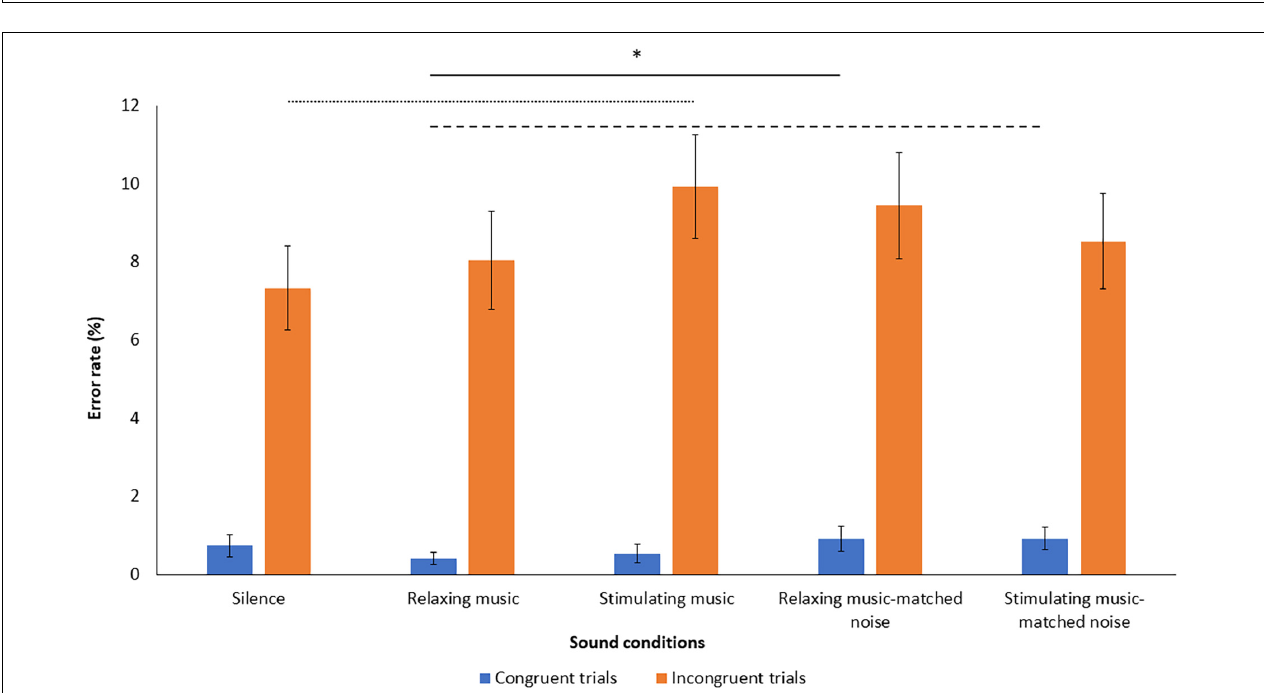
FIGURE 2 | Mean scores for the emotional judgments of valence and arousal and mean scores for the evaluation of familiarity for each sound condition. Graph shows standard errors. ∗∗ p < 0.01. ∗∗∗ p < 0.001.